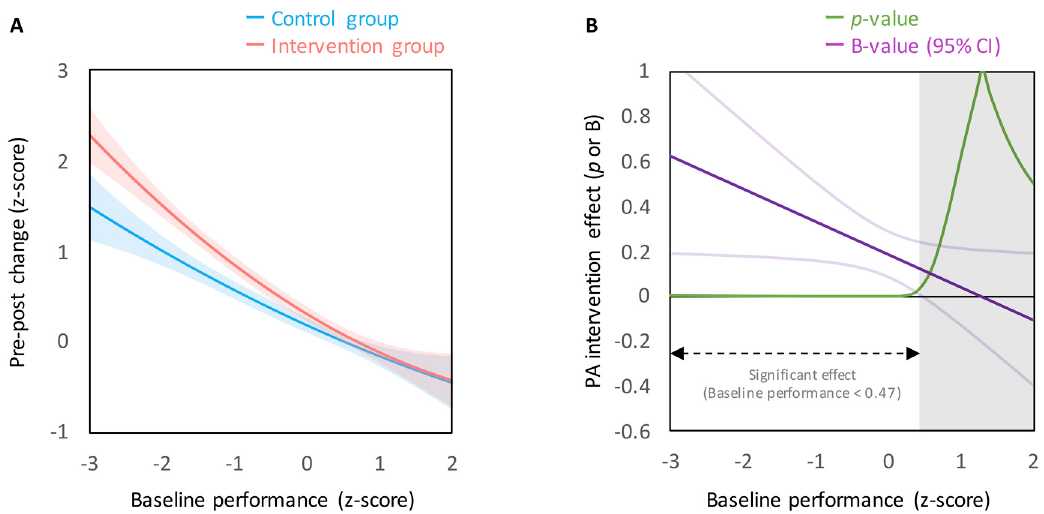
Figure 1. ( A ) Relationship between baseline performance and pre–post changes in cognitive performance, illustrating the group × baseline performance interaction. Regression lines are shown with 95% confidence bands (shaded areas). ( B ) Relationship between baseline performance and the PA (physical activity) intervention effects. The PA intervention effects were statistically significant if baseline performance was lower than mean + 0.47 SD .